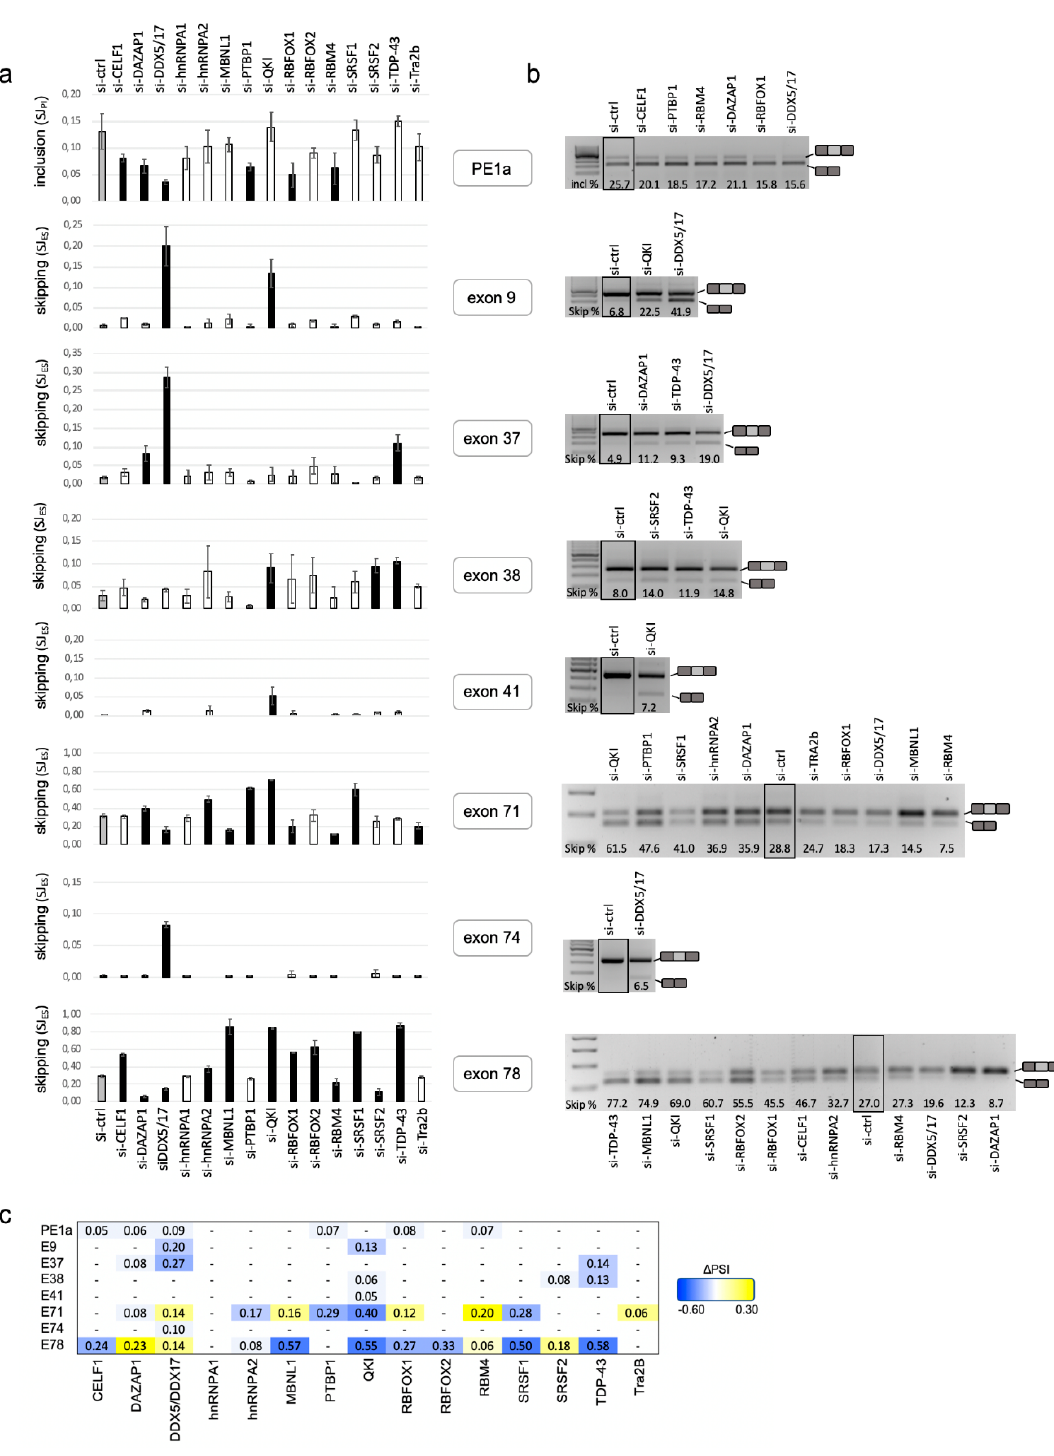
Figure 2. Splicing changes of DMD exons upon depletion of a set of RNA-binding proteins. ( a ) DMD-targeted RNA-seq data. Bar graphs showing the exon skipping level of seven DMD exons (usage of the splice junction (SJ ES ) resulting from the single exon skipping) or exon inclusion level of the pseudoexon 1a (PE1a) (usage of the splice junctions (SJ PI ) resulting from the insertion of the pseudoexon) as defined in the Supplementary Figure S2 upon depletion of 16 RBPs in d3-diff C25Cl48 cells. Cells transfected with the control siRNA (si-ctrl, grey bars). Black bars denote the changes in junction usage ( Δ SJ = SJ (si-RBP) − SJ (si-ctrl) ) above the threshold | Δ SJ| ≥ 0.05. Error bars represent the standard deviation from four (si-ctrl) or two (si-RBP) biological replicates. ( b ) RT–PCR validation